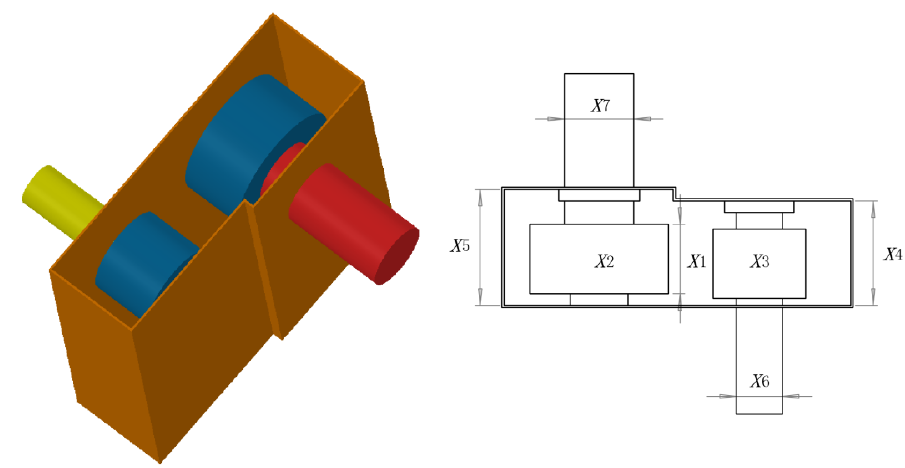
Figure 8. The speed reducer design problem is the 3D model diagram ( left ) and structural parameters ( right ).